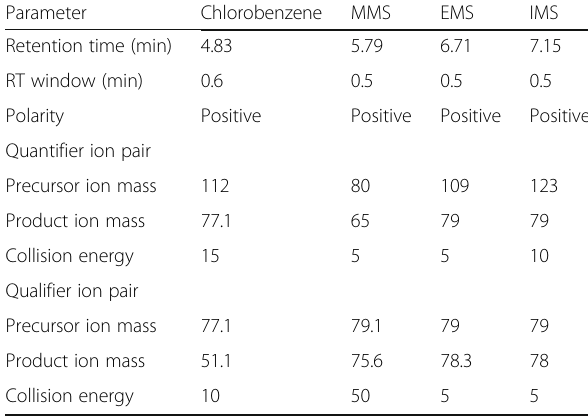
Table 1 Analyte-dependent MS parameters for SRM